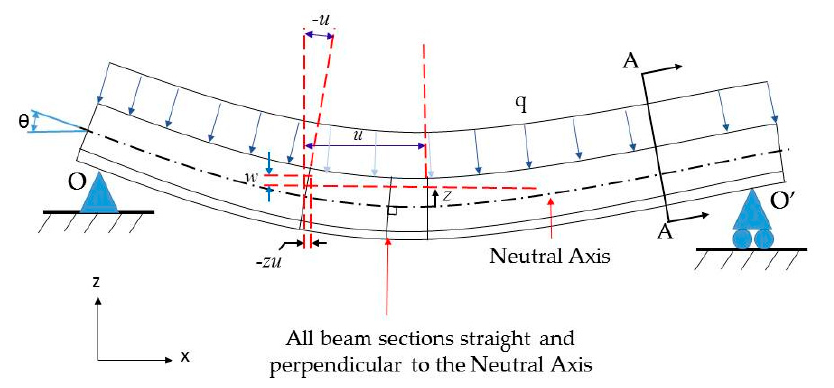
Figure 1. Displacement of the T-beam after bending.